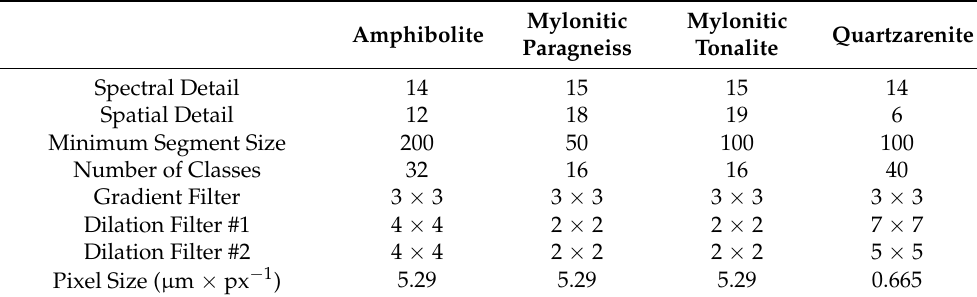
Table 4. Micro-Fabric Analyzer settings used to process the selected